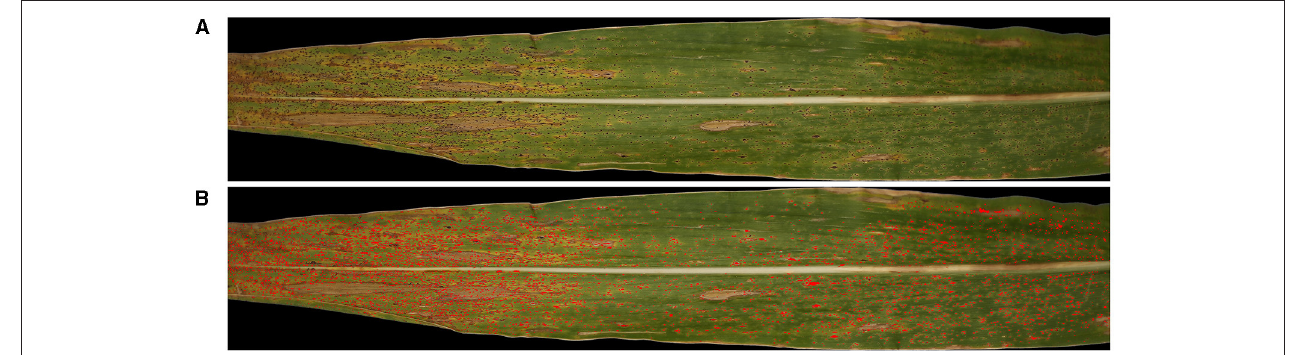
FIGURE 7 | Illustration, showing the (A) original Red-Green-Blue (RGB) image input (top) and the (B) resulting image after detection of stromata colored in red using the SCDA